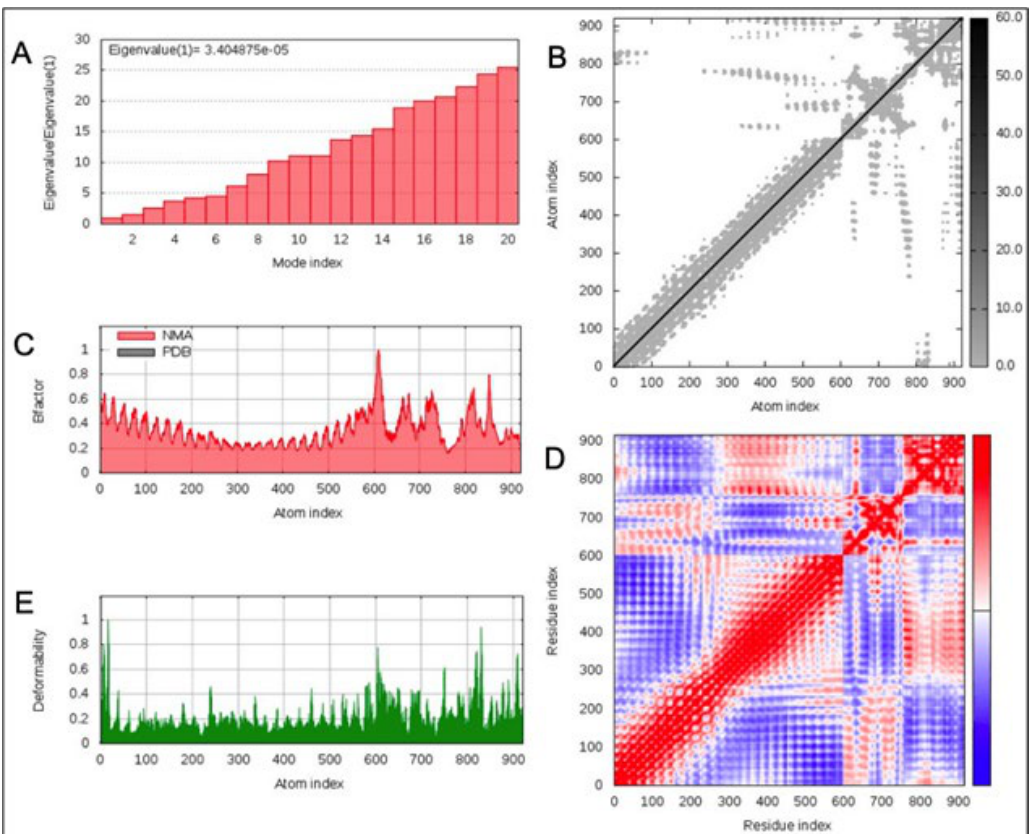
Fig. 9. (A) Eigenvalue of the vaccine-TLR-4 complex (B) Elasticity network mapping (C) Predicted experimental Bi- factor (D) Co-variance map (E) Main chain